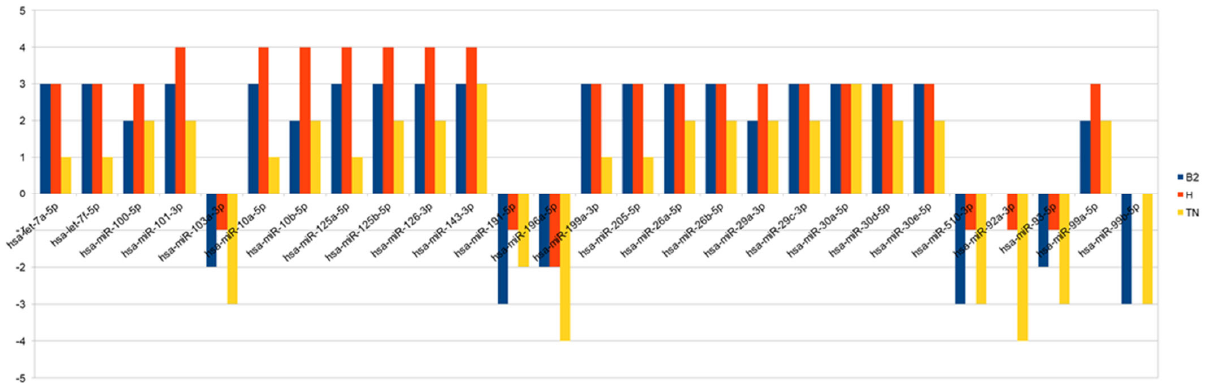
Scheme 1. The chart summarizes—for each miRNA and for each subtype—the number of samples that show the same over/under-expression pattern. Bars above the 0 represent overexpression, while bars below represent under ‐ expression. Table 4. miRNAs predictive target genes.